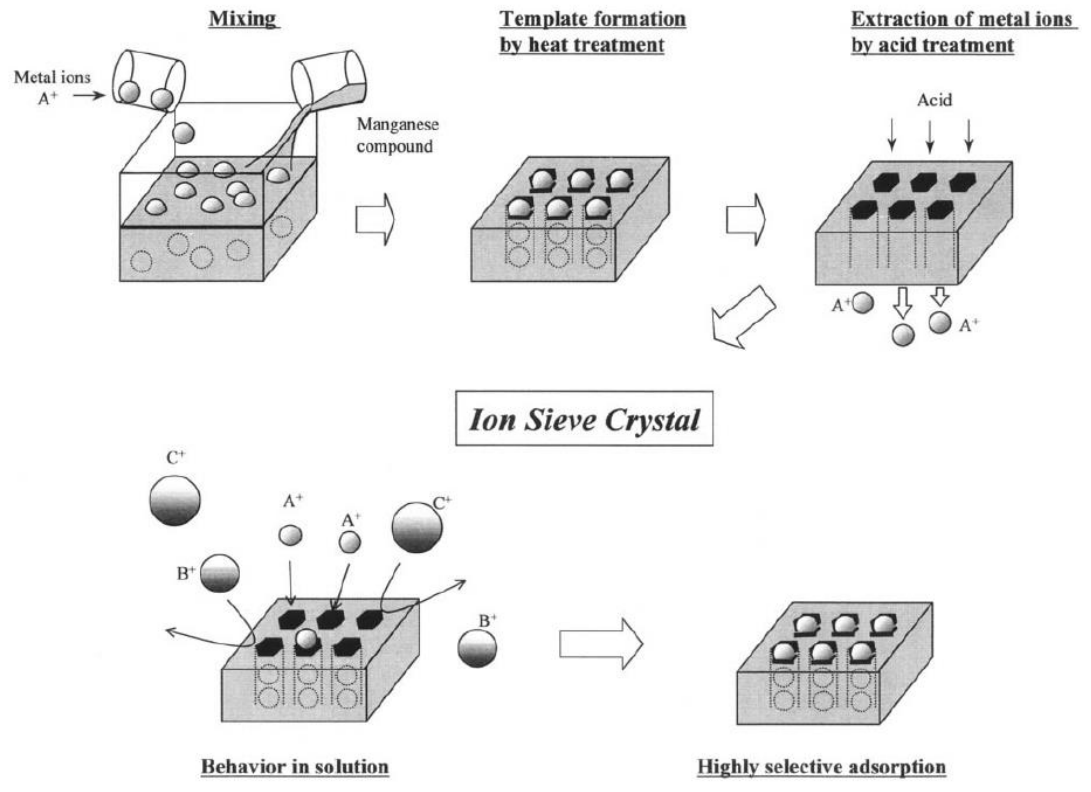
Figure 13. Schematic representation of synthesis of manganese oxide ion-sieve and ion-sieve behavior [139]. Republished with permission of the Royal Society of Chemistry, from Journal of Materials Chemistry, Manganese oxide porous crystals, Feng et al., v. 9(2), 319–333, 1999; permission conveyed through Copyright Clearance Center, Inc.